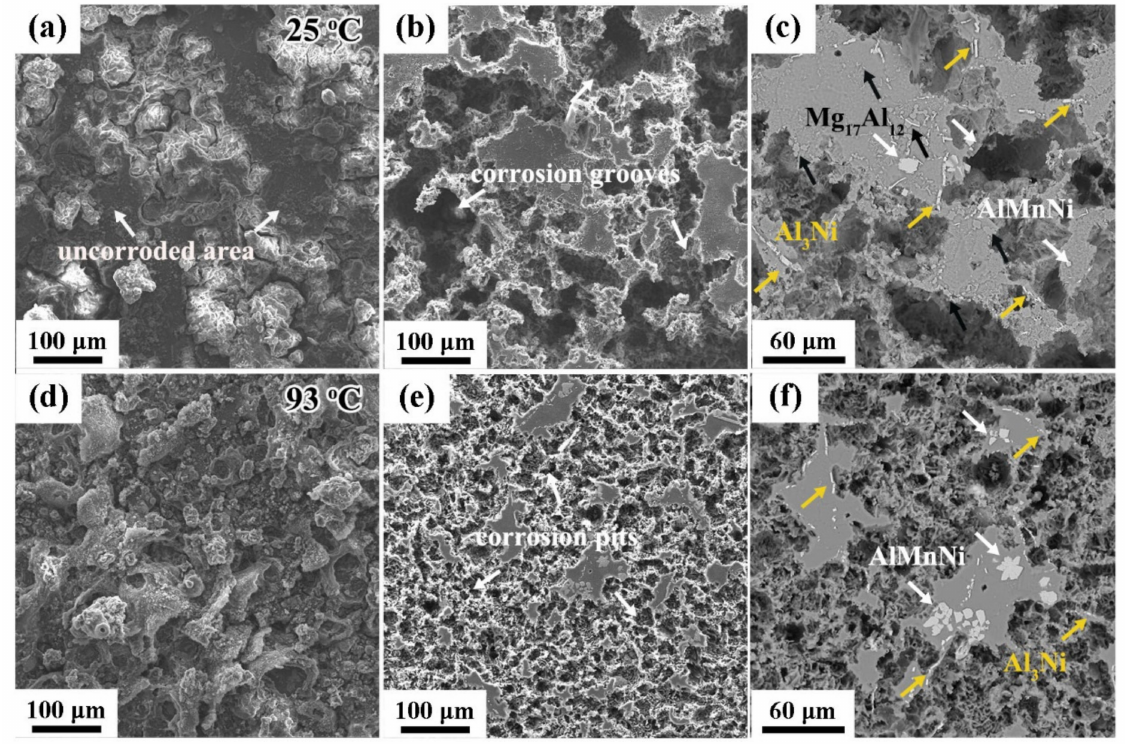
Figure 10. Micrographs of the AZN800-B alloys after being immersed in 3 wt.% KCl: ( a – c ) 2 h at 25 ◦ C, ( d – f ) 10 min at 93 ◦